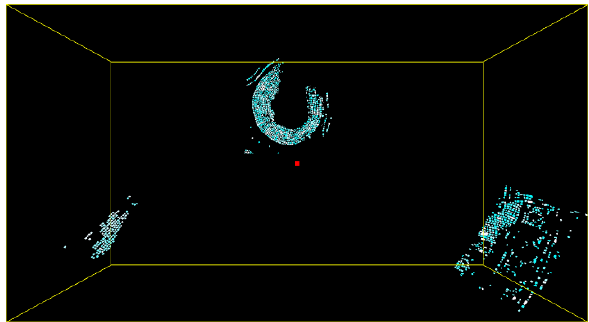
Figure 10 Bounding box (yellow) and its centre (red) related to the golden tesserae (bottom-up view) From each camera position, we compute the number of visible tesserae from the user request observed in the produced image. Since each instance of one sort of tesserae is coloured uniquely, Figure 9 Unique colourisation of a group of golden tesserae the algorithm performs by counting the number of different (bottom-up view) pixels colours. Hence the number of distinct colours in the image corresponds to the number of tesserae seen from this camera position. The visibility of a tessera is fixed at one pixel but it can be changed according to the users’ needs. The camera position that maximises the view of requested tesserae corresponds to the optimal viewpoint. If two camera locations present the same number of observed tesserae, we apply a maximisation criterion regarding the pixels to determine the optimal camera position.